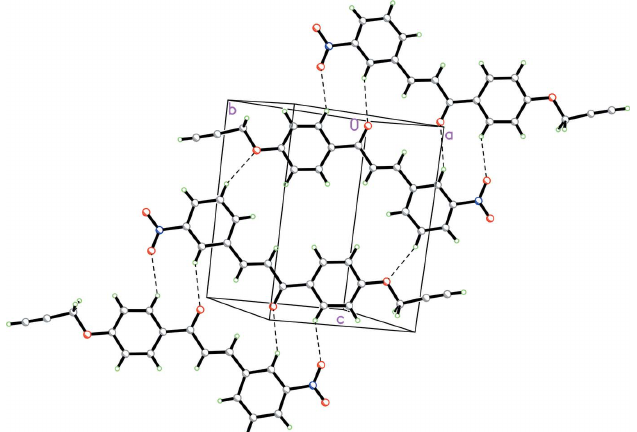
Figure 3 Reaction scheme for the synthesis of the title compound.